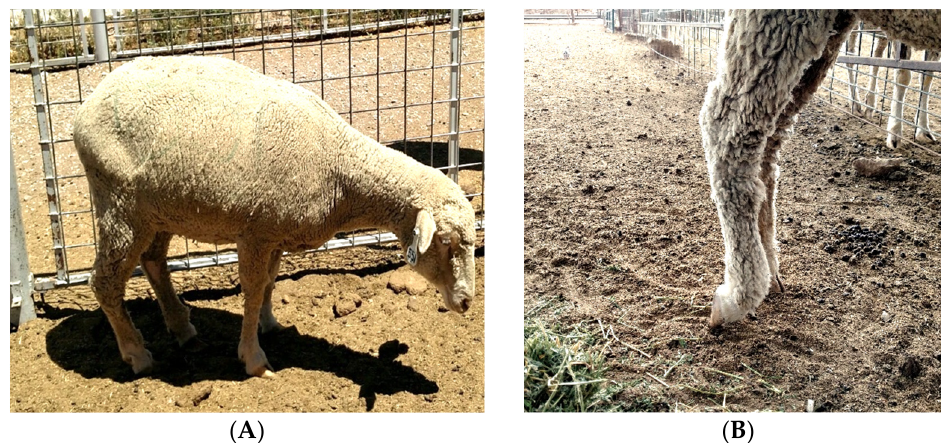
Figure 1. Predominant symptoms observed included: ( A ) ewe demonstrating difficulty walking and standing with its head down; ( B ) knuckling of the feet as a result of ingested contaminated-feed. Treatments began on the morning of 18 April 2019. All ewes showing symptoms were treated with 60 mL of sodium bicarbonate, 10 mL of Bismuth subsalicylate, 3 mL of Banamine ® , and were placed into a separate sick